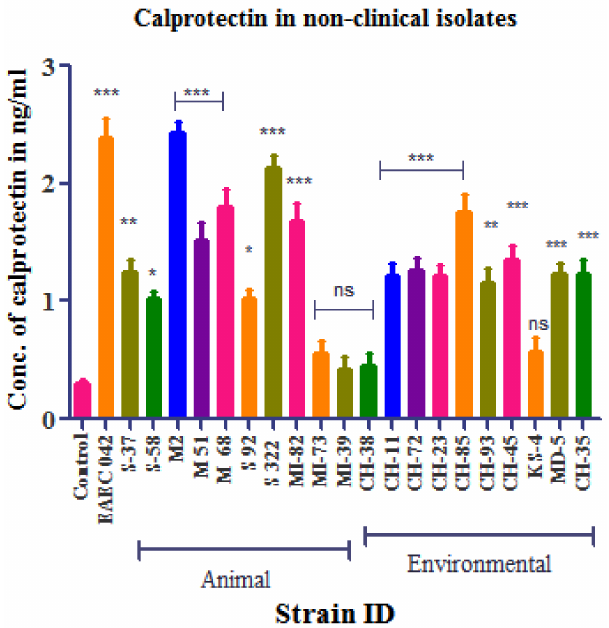
Figure 6. The concentration of calprotectin (ng/mL) in BALB/c mice infected with the EAEC strain of environmental and animal origin. * p , 0.05; ** p , 0.01; *** p , 0.001; comparison by one-way ANOVA with Dunnett’s multiple comparison tests. NS =